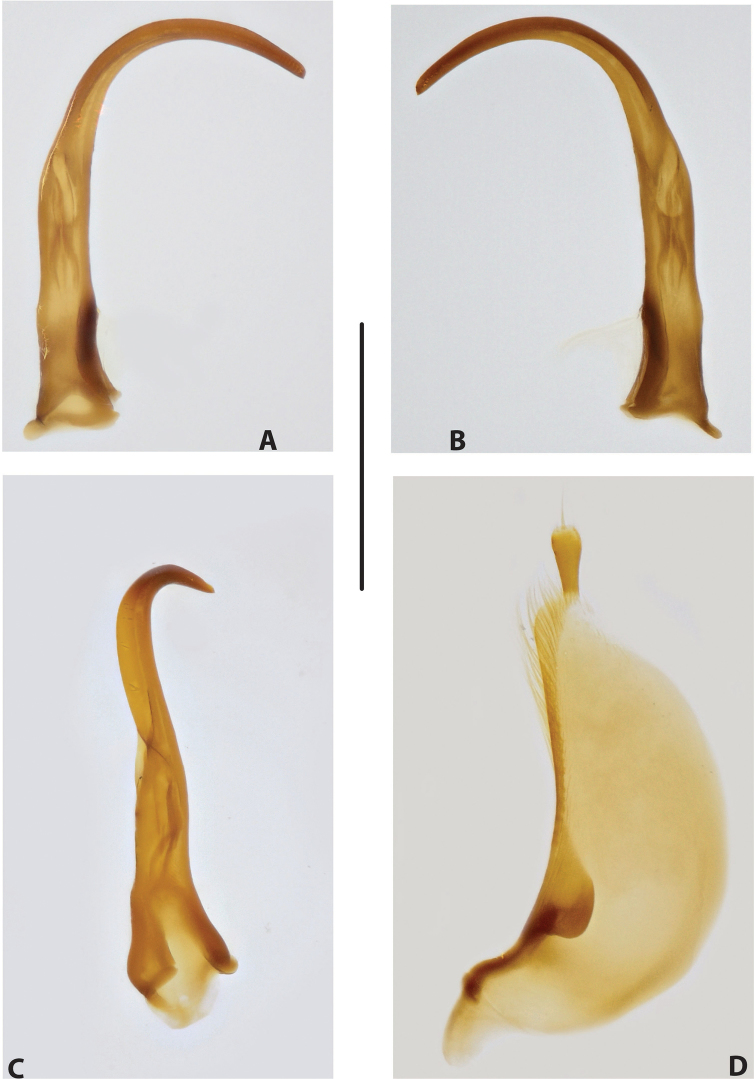
Copelatus
tenebrosusA median lobe in lateral view, right side B median lobe in lateral view, left side C median lobe in ventral view D left paramere in external view. Scale bar: 0.5 mm.